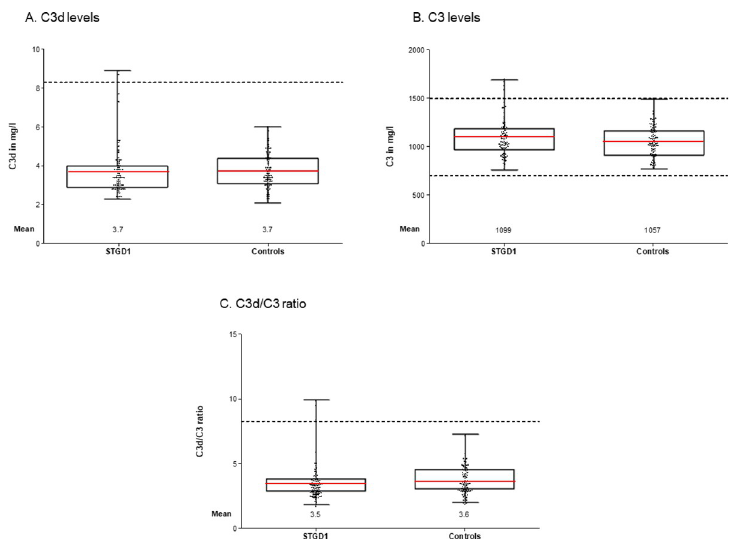
Fig 1. Complement activation levels in Stargardt disease (STGD1) patients and controls matched for age and sex. Level of (A) C3d, (B) C3, (C) C3d/C3 ratio in STGD1 patients and controls. Dotted lines represent the reference values. Red lines represents the mean. There were no significant differences in means between patients and controls as tested with an independent samples t-test. C3, complement component 3; C3d, complement degradation product C3d.